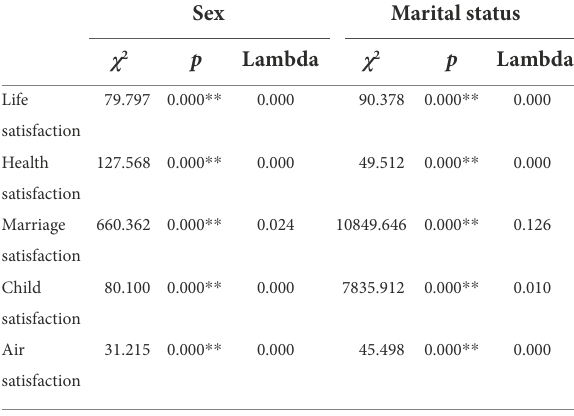
TABLE 3 The chi-square test between sex, marital status and the five dimensions of subjective well-being ( n =